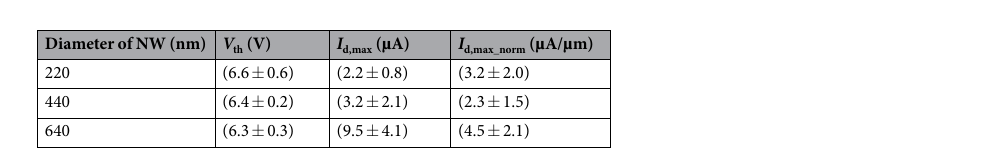
Table 2. DC characteristic results of single vertical n-p-n GaN NW FETs (average value) with three different diameters of 220 nm, 440 nm, and 640 surface charge does not only increase the threshold voltage as shown in Fig. 6f, but also contributes to the deple- tion of the drift region, which can be seen from the increase of resistivity in Fig. 6e. With increasing negative surface charge, the junction depletion region extends more into the drift region that contributes to the turn-on voltage in the output characteristics. It is remarkable that for a short gate configuration, the electric field in the drift region near the junction to the channel is larger than the field near the drain region, which exhibits a high resistivity. However, for a long gate architecture, this effect is not found (see SI Fig. S5a,b). The measured BVs of the 1, 9, and 100 NW FETs were verified from 30–90 V at V gs = 0 V as shown in SI Fig. S4. Theoretically, the BV is determined by the length and doping concentration of the drift region. In these devices, the space between drain and gate channel is ~1 µ m, which is much shorter than our previous device having BVs of 54–92 V 13 . However, for improving the device design and performance, several strategies can be proposed for the next transistor generations, e.g., decreasing the Si-doping concentration in the drift region, integrating vertical field-plate structure, and employing longer drift region. The low doped and longer space drift region will reduce the local electric field and thus the BV can be increased 20,29,52 .